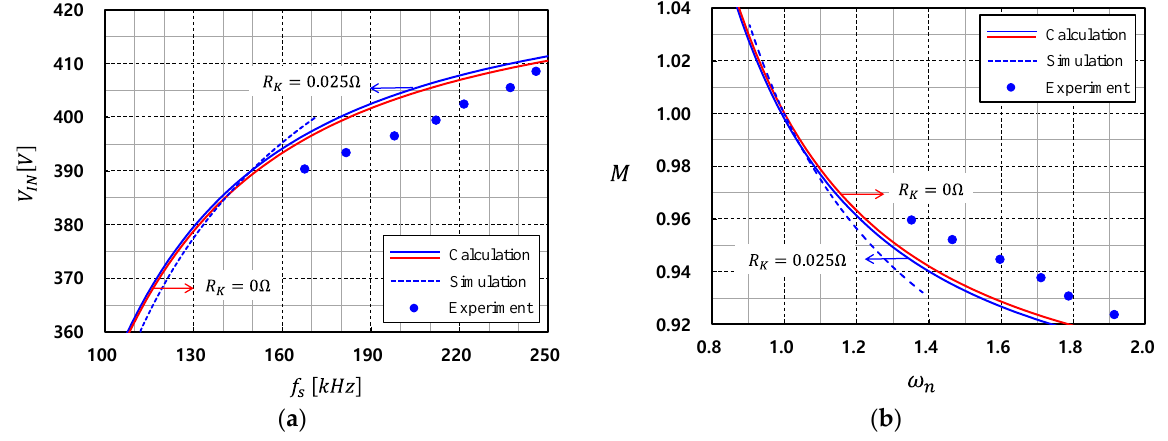
Figure 19. Frequency characteristics of DC voltage gain M at low load current: ( a ) Input voltage characteristics in accordance with switching frequency variation; and ( b ) DC voltage gain M characteristic in accordance with normalized frequency variation.